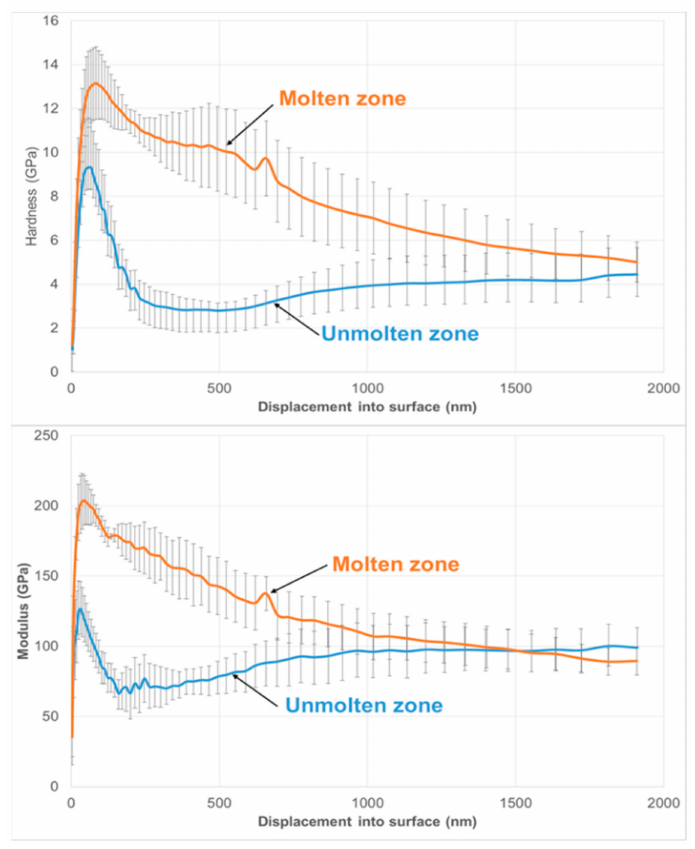
Figure 6. Hardness and modulus at different penetration depths of the Al 2 O 3 /TZ-3YS coating in different